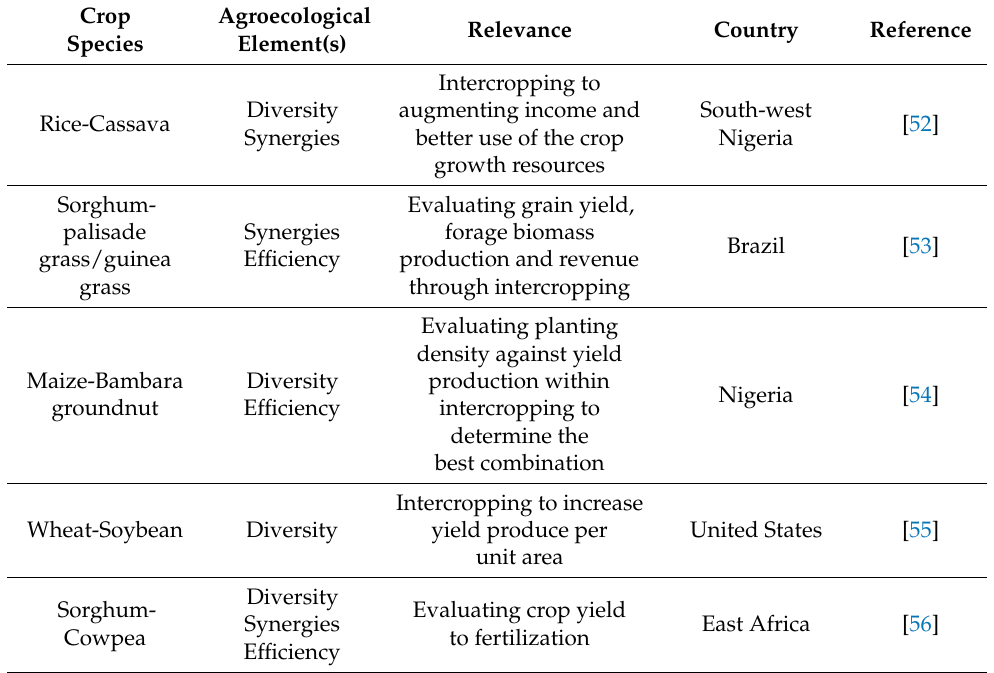
Table 1. Examples of cereal research involving the adoption of agroecological